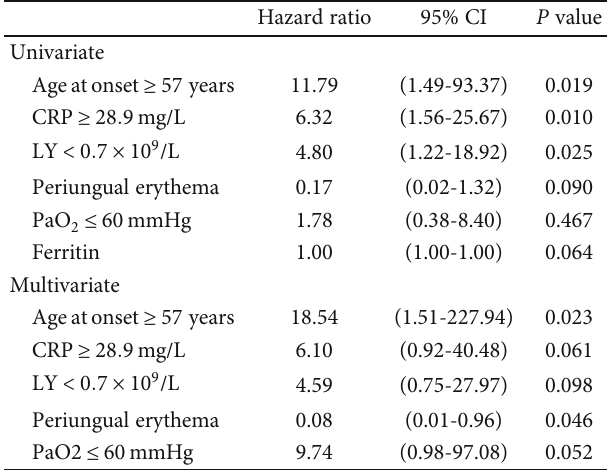
Table 4: Survival analysis in anti-MDA5-associated